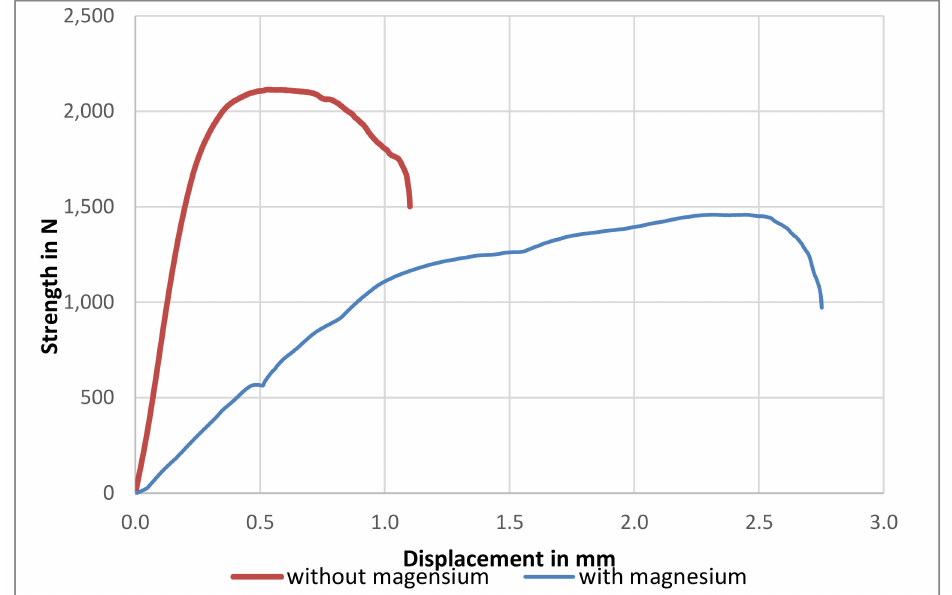
Figure 10. Strength and displacement curves for the dissimilar joints with zinc and zinc + magnesium layer on the steel sheets (exemplary).